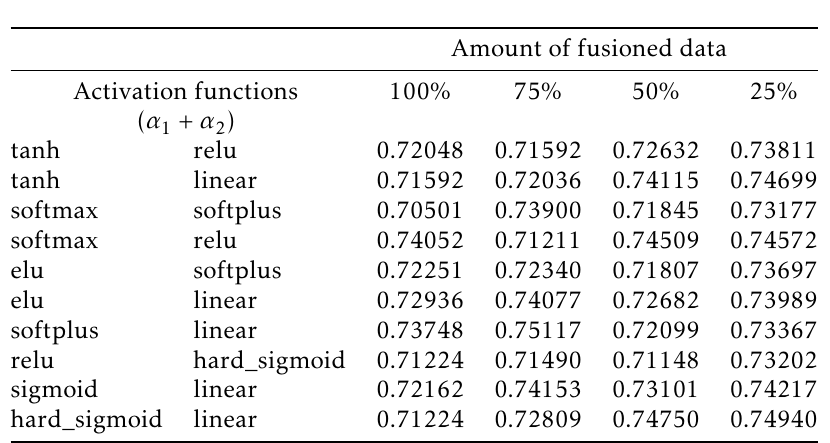
Table 3. Tuple of the ten highest activity recognition model results for Subject 2, which benchmark is 0.60114.